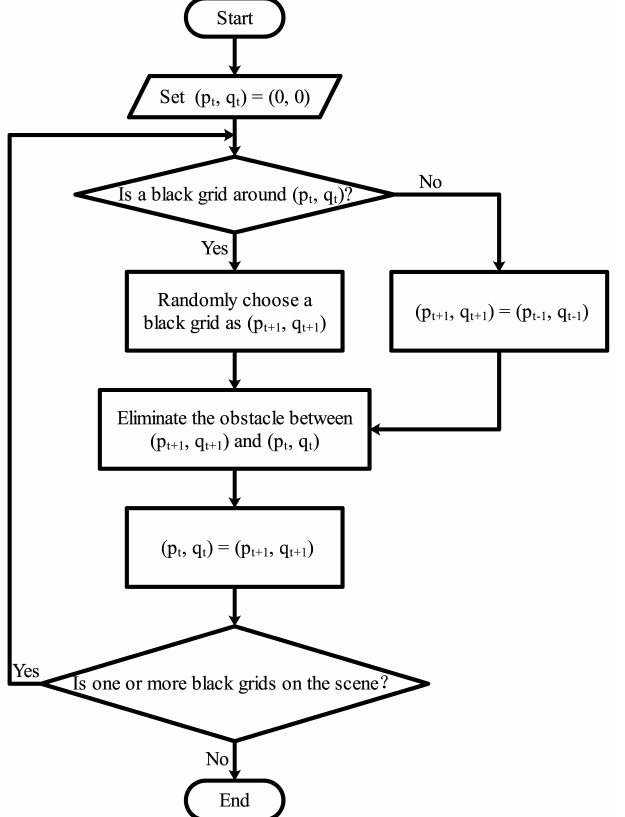
Figure 4. The complete mechanism flow utilized to generate a new maze scene in